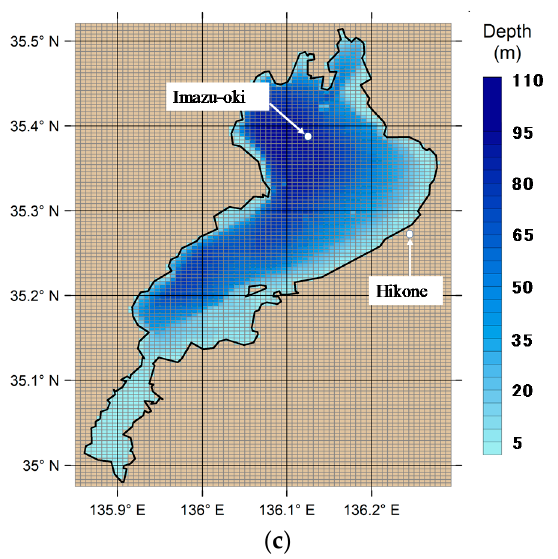
Figure 1. ( a ) The location of Lake Biwa in Japan; ( b ) the location of rivers; ( c ) the water depth of Lake Biwa.